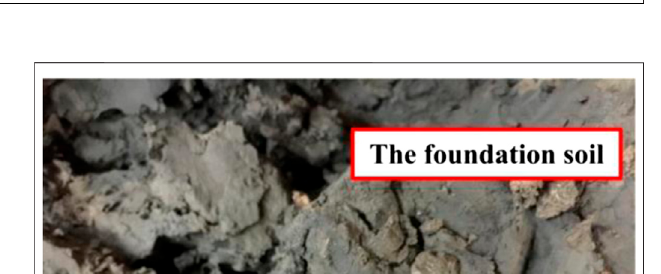
FIGURE 1 | Large scale indoor model test loading system.